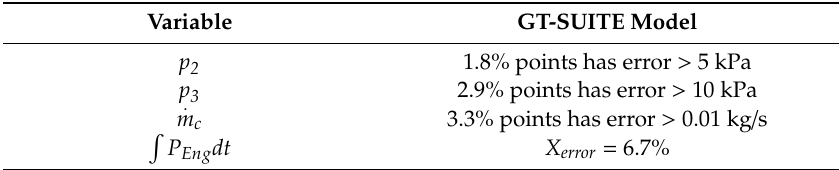
Table 4. Estimation error of the GT-SUITE model.